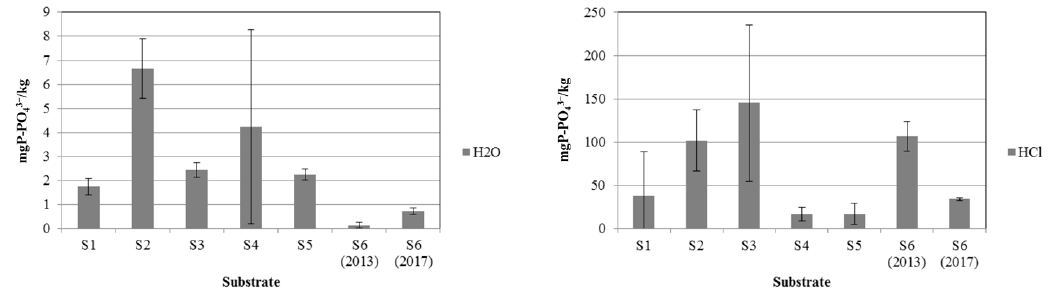
Figure 2. Total P-PO 43 − content (mg/kg) in substrates extracted by using hydrochloric acid (HCl) and leachable P-PO 43 − extracted by using distilled water (H 2 O) in the batch test (mean value and standard deviation).